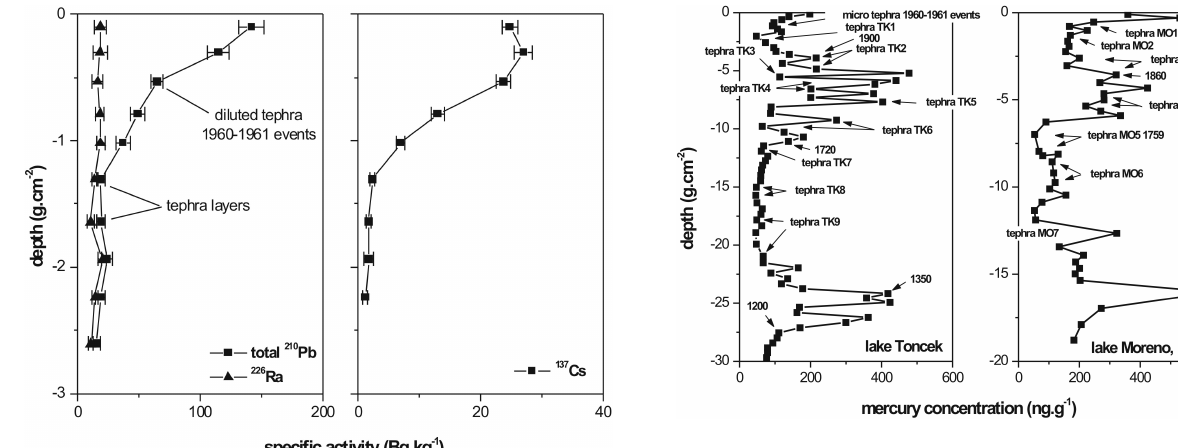
Fig. 4. Mercury concentration profiles. Lake Tonˇcek and Lake Moreno Oeste (Llao Llao bay) sedimentary sequences.